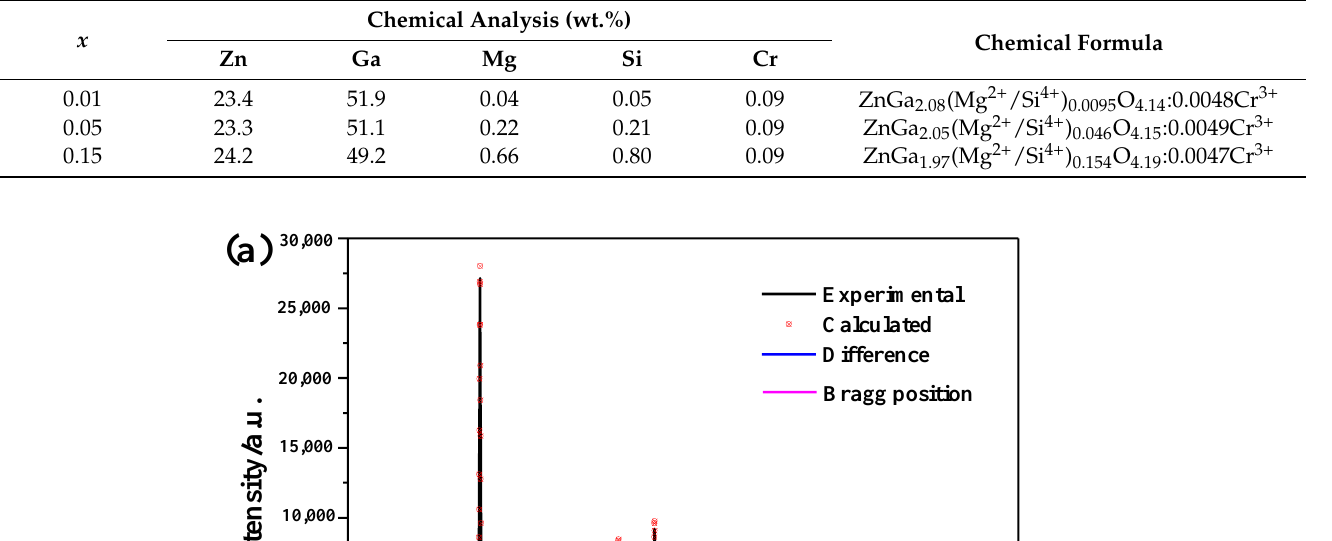
Table 1. Results of chemical analysis for ZGMSO:Cr 3+ ( x = 0.01, 0.05, 0.15).